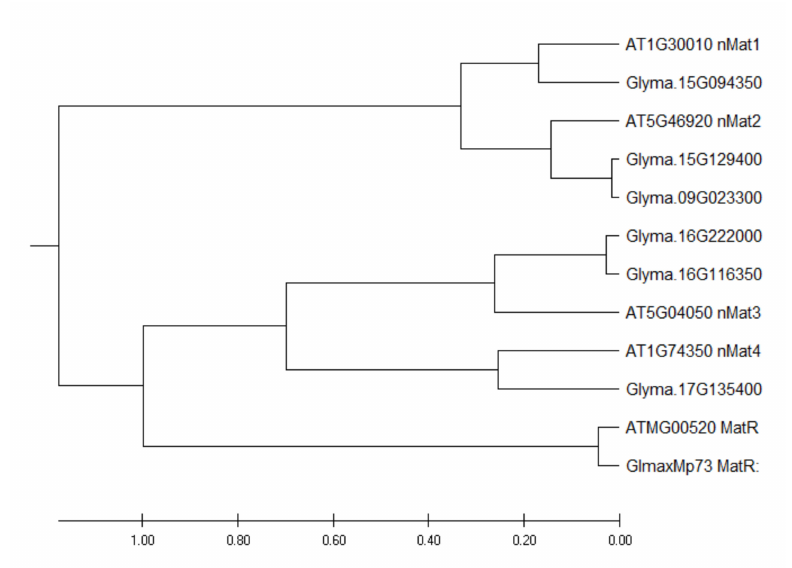
Figure 2. Phylogenetic tree of soybean intron maturases. Evolutionary analysis was conducted with MEGA X using the Unweighted Pair Group Method with Arithmetic Mean (UPGMA) method